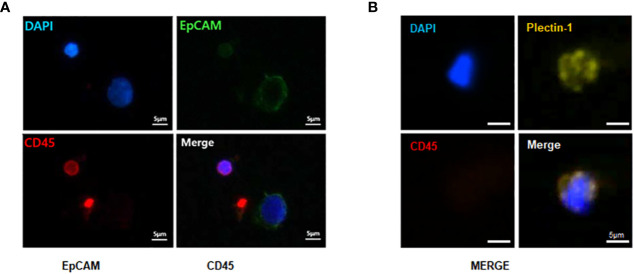
Immunofluorescence staining of captured circulating tumor cells (CTCs) from patients with resectable pancreatic ductal adenocarcinomas (PDACs). To identify CTCs, captured CTCs from PDAC patients were immunostained with anti-epithelial cell adhesion molecule (EpCAM) (green), anti-Plectin-1 (gold) and anti-CD45 (red) antibodies. Nuclei were counterstained with DAPI (blue). CTCs are (A) EpCAM+ or (B) Plectin-1+ among CD45-DAPI+ cells. Scale bar, 5 μm.